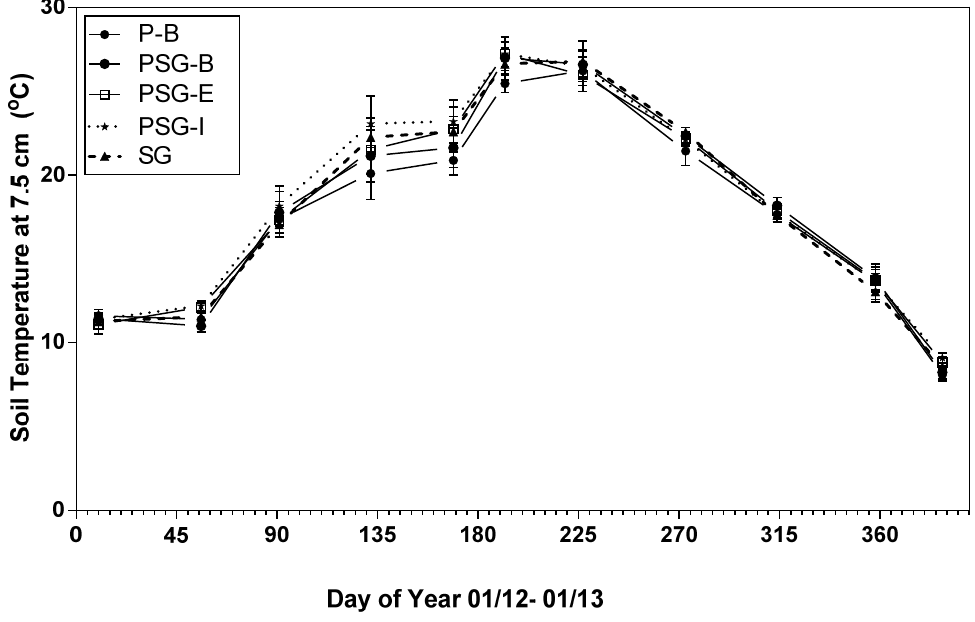
Figure 2. Mean soil temperature ( ◦ C at 7.5 cm) from 10 January 2012 to 19 January 2013 in a four-year-old switchgrass and loblolly pine agroforestry system on the lower coastal plain of North Carolina. Error bars represent ± 1 standard error of the mean. P = pine, SG = flat planted switchgrass, and PSG = pine intercropped with switchgrass. Additional treatment designations indicate the microtopographical position of the sample location where B = bedded row, I = interbed space, and E = edge where an aboveground transition from switchgrass to pine was observed.